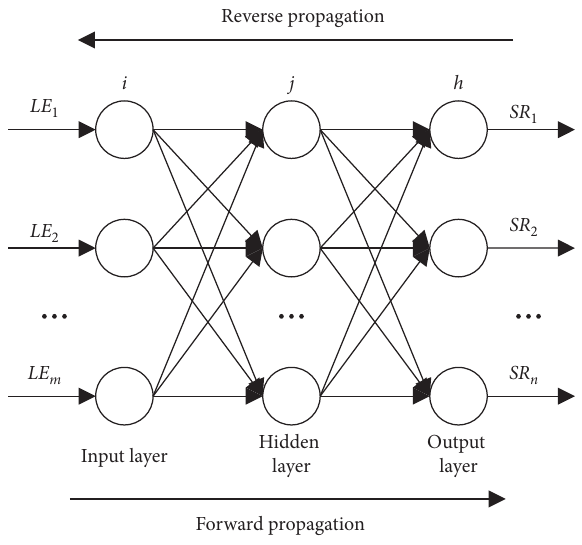
Figure 2: Structure of BP neural